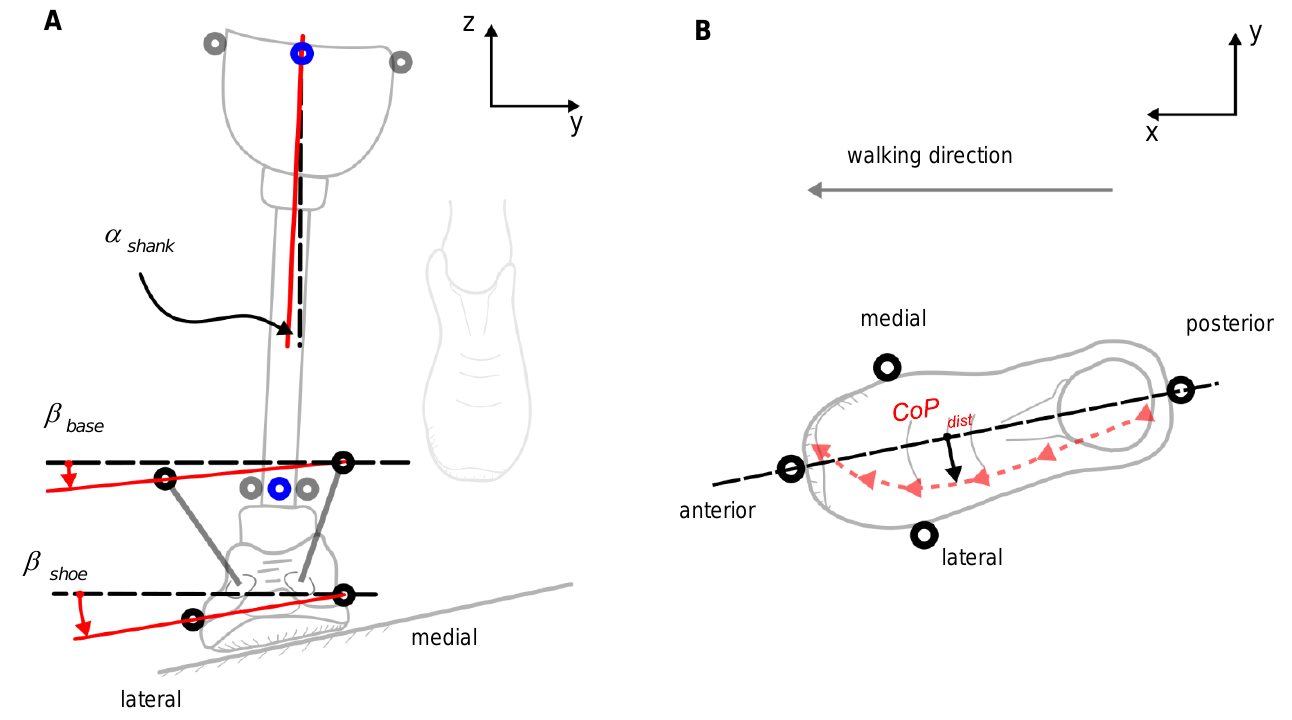
Figure 2: Diagram to introduce the parameters used. (A) Shank and foot from frontal view: Markers, symbolized by circles, were projected in the frontal plane (y-z plane) to calculate  shoe ( medial and lateral shoe marker),  base (medial and lateral antenna marker) and  shank (virtual center of knee and ankle marker). These parameters were used to estimate the relative adaptation  shoe and  base to cross-slopes. The external knee adduction moment (EKAM) was calculated using the virtual center of the knee (blue marker, middle of lateral and medial knee markers) and the ground reaction force (using cross product in lab coordinate system). (B) foot from transversal view (lab coordinate system): CoP dis t , the orthogonal distance between the CoP course (red-arrow line) and the foot axis (black-dashed line, defined by tip and heel marker), was calculated on the cross-slope surface. Note, the cross-slope surface is tilted (10°) relative to the shown transversal plane (x-y plane) shown